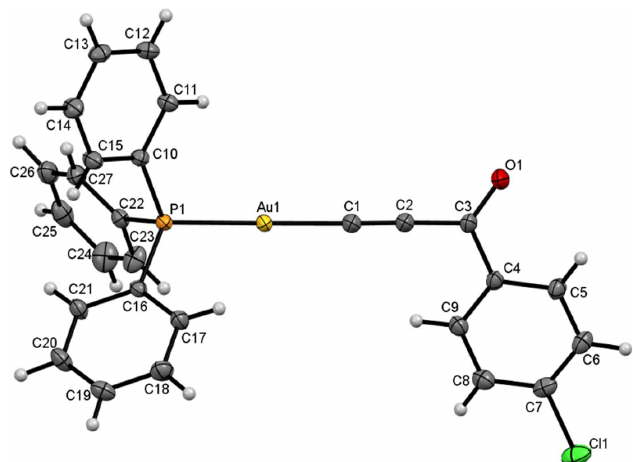
Figure 2 Molecular structure of the investigated gold(I) compound for the Ag K (cid:4) data after IAM. The labeling scheme applies to all further refinements. Ellipsoids are drawn at the 50% probability level. Hydrogen atoms are shown as small spheres of arbitrary radius.